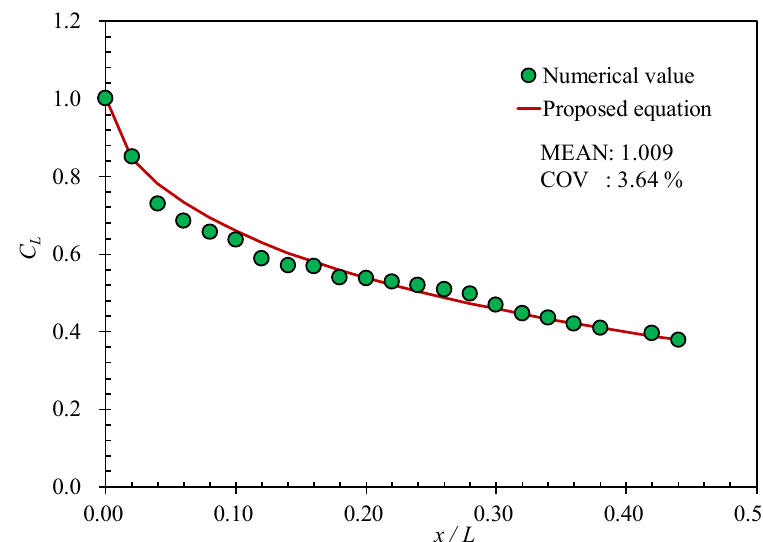
Figure 9. E ff ects of impact location on the extent damage of ring-sti ff ened cylinder. Figure 9. Effects of impact location on the extent damage of ring-stiffened cylinder.